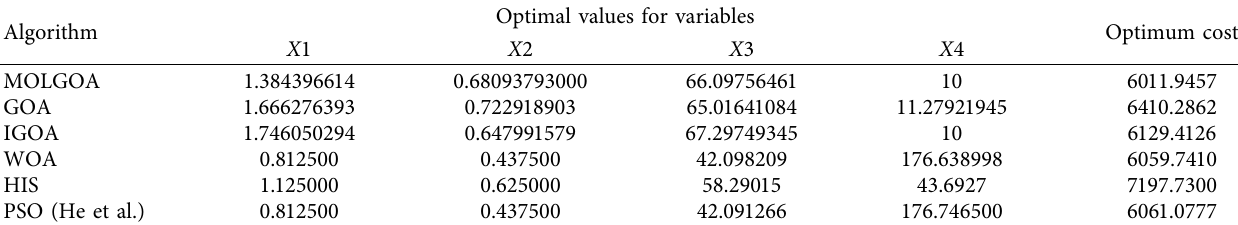
Table 12: Comparison results of the PV